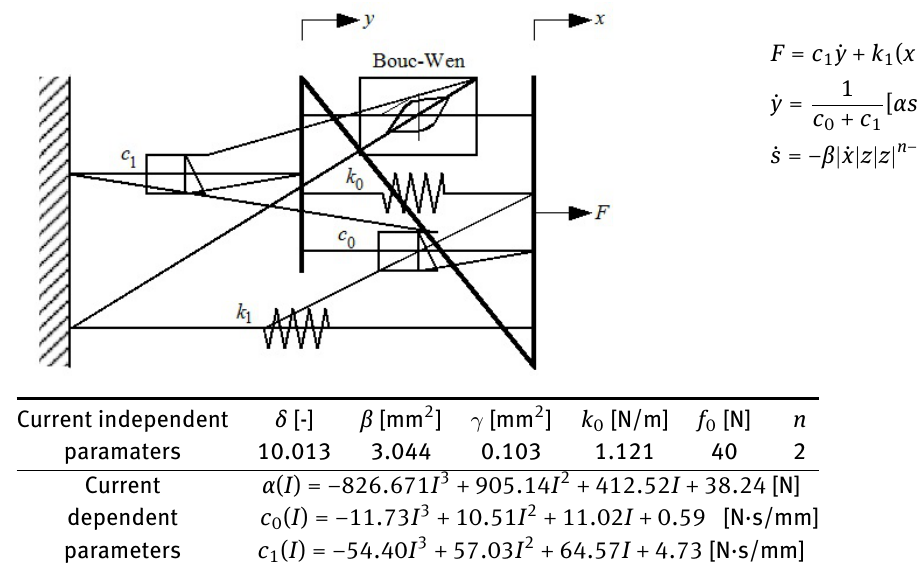
Table 1: Modified Bouc-Wen model - Parameters of the RD-1005-3 MR damper